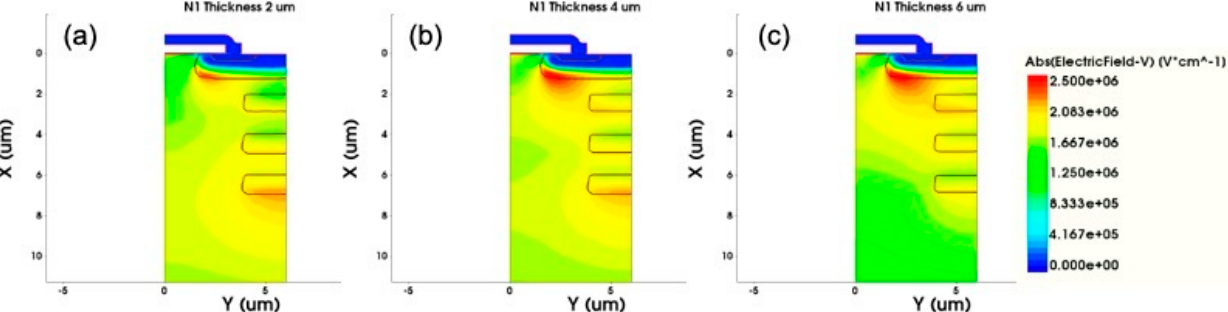
Figure 7. The electric field distribution diagrams of different N1 epitaxial layer thicknesses ( a ) 2 μ m, ( b ) 4 μ m, ( c ) 6 μ m.